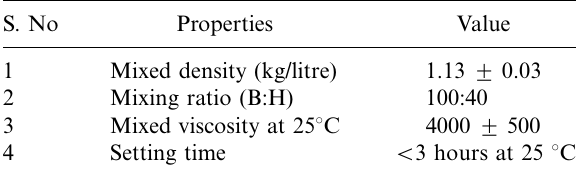
Table 3. Properties of saturant S.